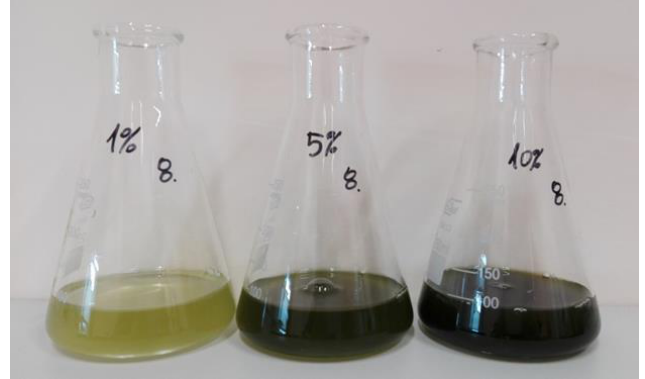
Figure 1. Extracts obtained from clone number 8 (1%, 5%, and 10%).